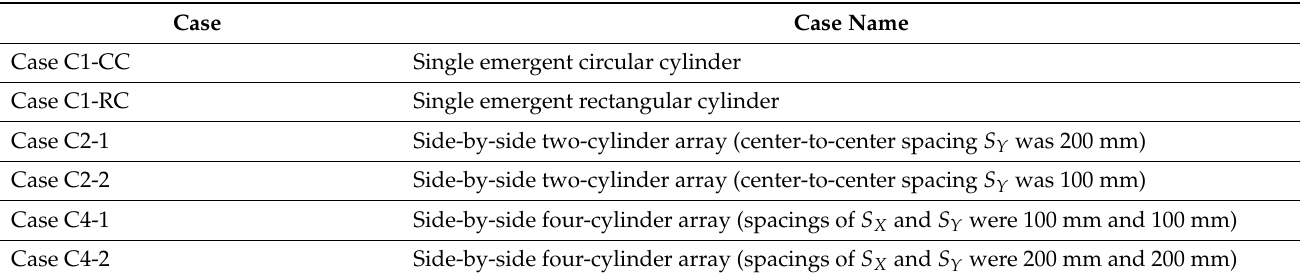
Table 2. Experimental cases